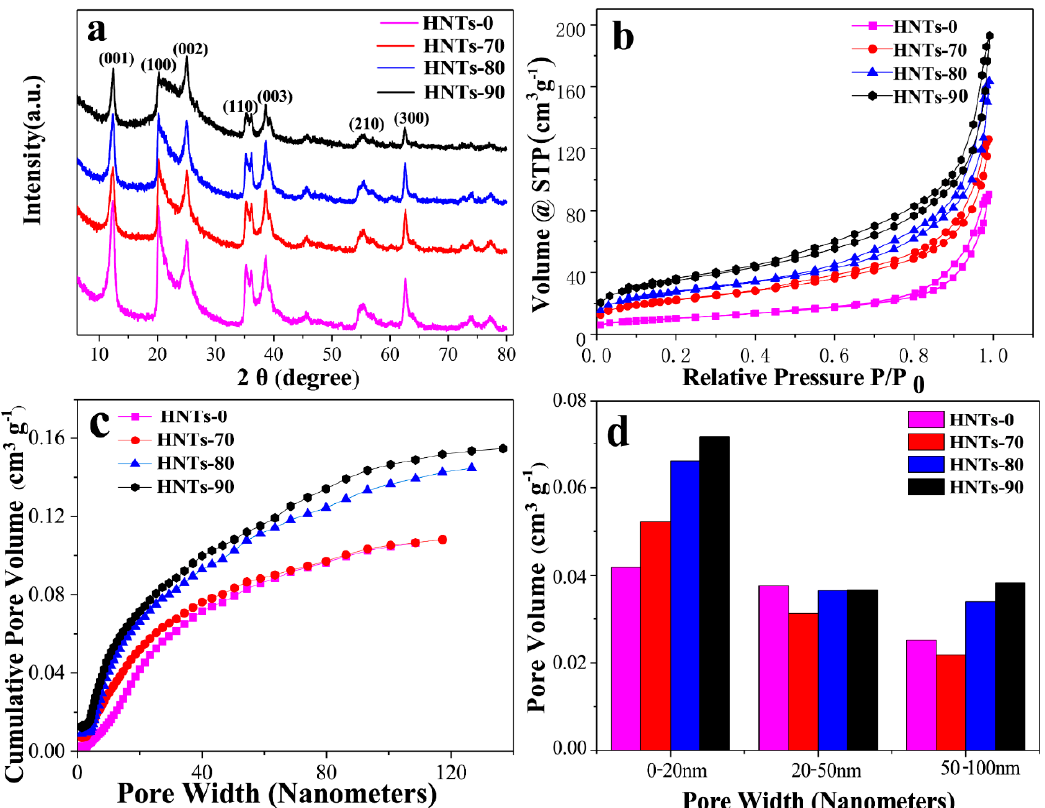
Figure 1. ( a ) X-ray diffraction patterns; ( b ) Nitrogen adsorption/desorption isotherms; ( c ) Cumulative Pore Volume vs Pore Width Curves and ( d ) Pore size distribution histogram of HNTs with different etching temperature (70 °C, 80 °C, 90 °C).